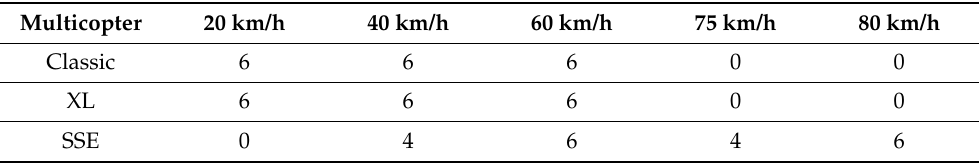
Table 2. Number of fly-bys per multicopter and speed in the forward flight experiment. Multicopter